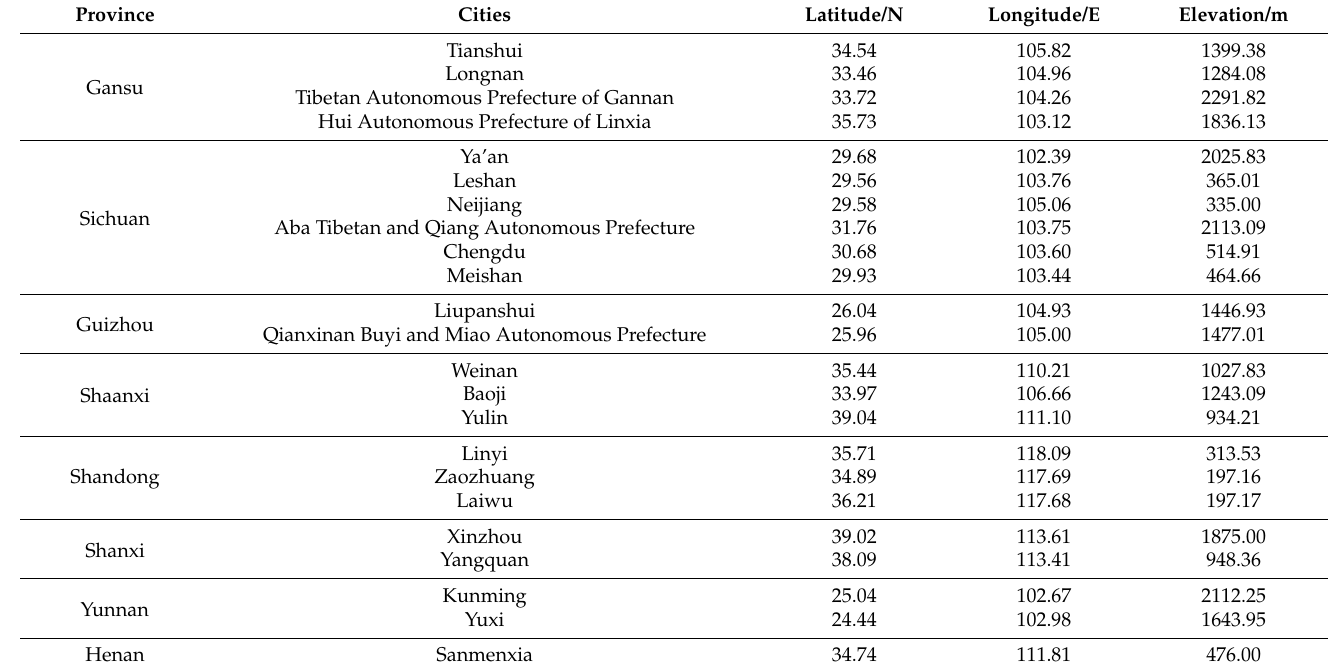
Table 1. Areas of sample collection along with GPS data and altitudinal information.